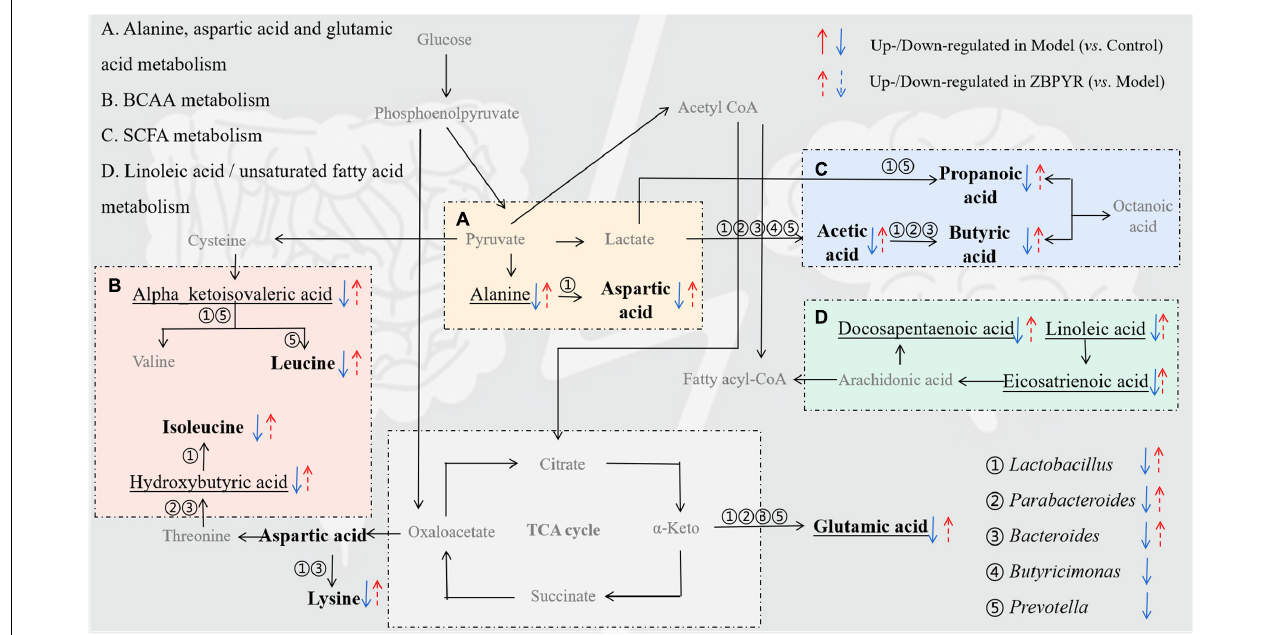
FIGURE 9 | Schematic diagram showing the regulation of ZBPYR treatment on the network of differentiated bacterial and metabolite structural components. (A–D) , enriched metabolic pathways; (cid:172) – (cid:176) , differential bacterial genera; bold, differential intestinal metabolites; underline, differential hippocampus metabolites. BCAA, branched chain amino acid. SCFA, short-chain fatty